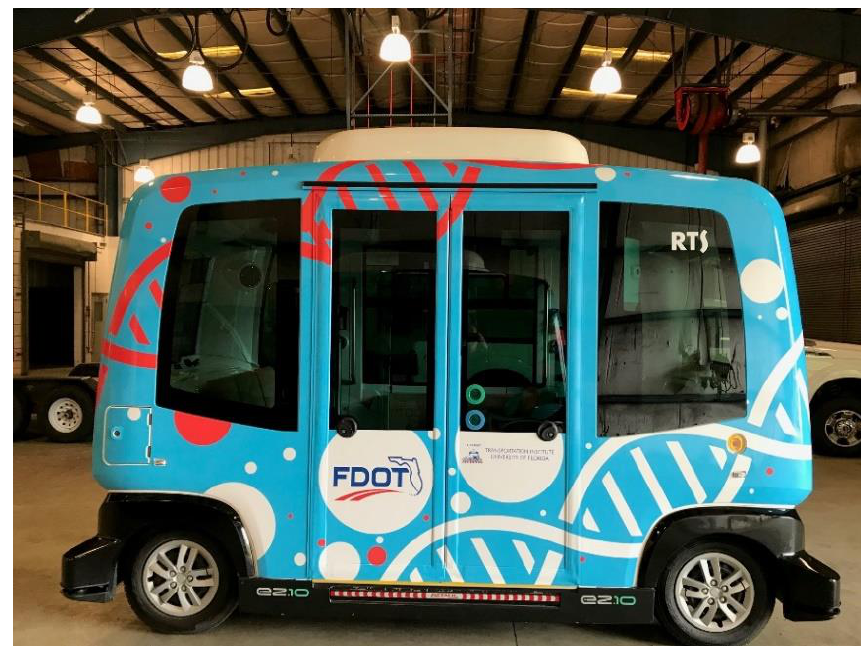
Figure 3. Transdev: EasyMile EZ 10 (Level 4, SAE).